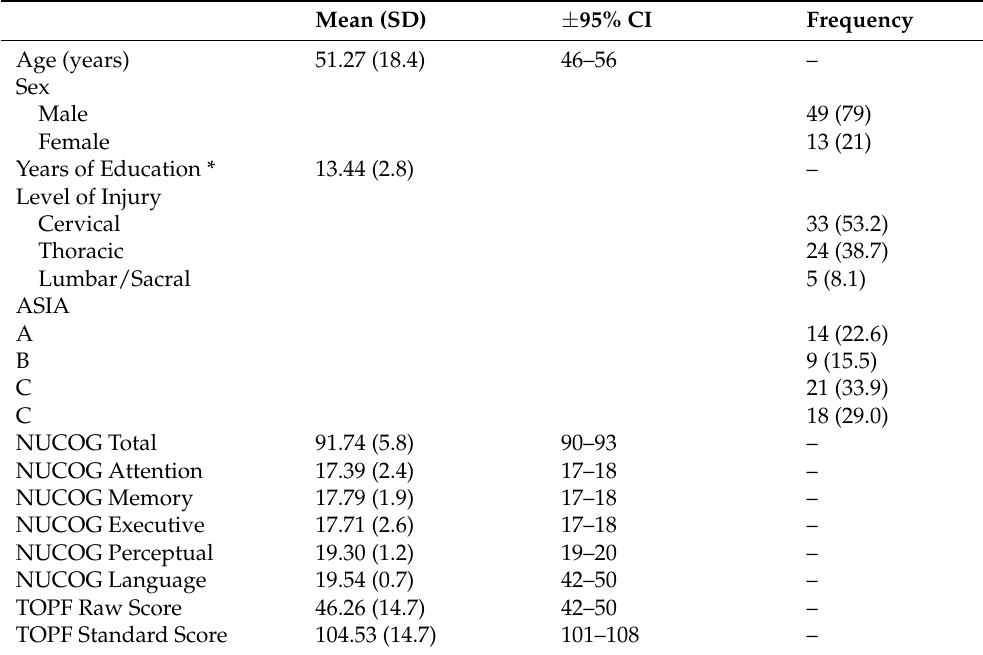
Table 1. Socio-demographic, injury characteristics, NUCOG total, NUCOG domains, and Test of Premorbid Functioning raw and standard scores for the 62 SCI